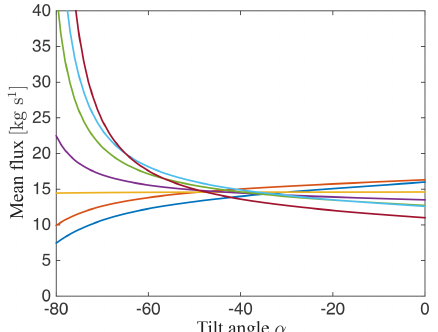
Figure 10. Mean fluxes of seven different cross sections of the mea- surement data set as a function of the angle correction. Each cross section is plotted in a different colour. The SO 2 flux should be the same in each cross section if it is a conservative tracer. The plume inclination can be estimated to 40 ◦ with an uncertainty of 5 ◦ . Along with knowing the orientation of the camera set-up, this information can be used to determine the plume propagation direction.